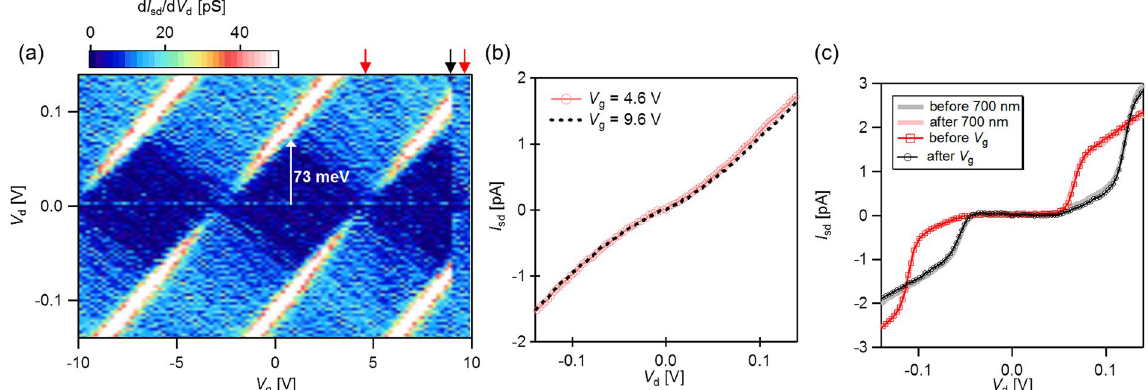
Figure 3. ( a ) Stability diagram of the MFG–SET after light irradiation. ( b ) Comparison of the I sd − V d characteristics before and after V th . ( c ) Comparison of the I sd − V d curves before and after 700 nm light irradiation and applied V g